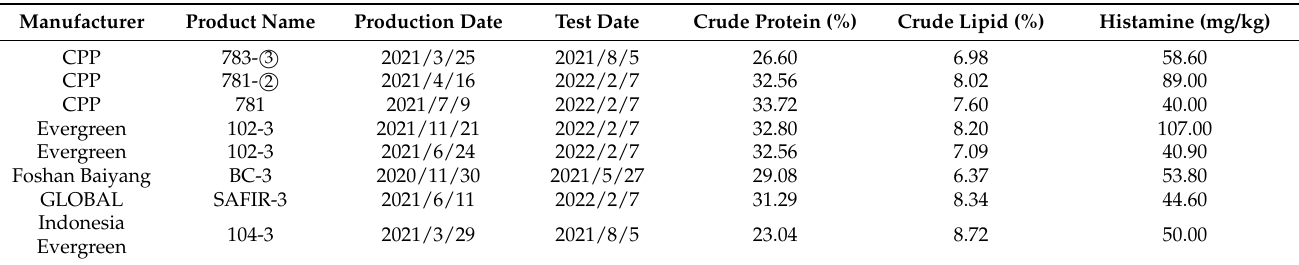
Table 1. Histamine content of commercial